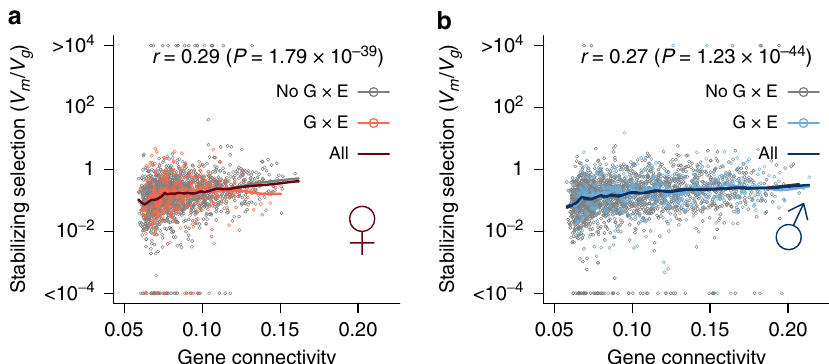
Fig. 6 Positive correlation between gene connectivity and strength of stabilizing selection. The strength of stabilizing selection as measured by the ratio between mutational variance ( V m ) and standing genetic variance ( V g ) is plotted against gene connectivity (mean | r | for expression at 25 °C) in females ( a ) and males ( b ). The dark lines are LOESS smooth lines with a span of 0.1. The colors of the points and lines indicate genes with no G×E, G×E, or all genes. Spearman ’ s correlation ( r ) and the corresponding P values were also indicated for all genes. In females ( a ), the Spearman ’ s correlation ( P value) is 0.30 ( P = 1.06 × 10 − 37 ) for genes without G×E, 0.19 ( P = 5.11 × 10 − 4 ) for genes with G×E. In males ( b ), the Spearman ’ s correlation ( P value) is 0.27 ( P = 5.06× 10 − 35 ) for genes without G×E, 0.21 ( P = 3.89 × 10 − 6 ) for genes with